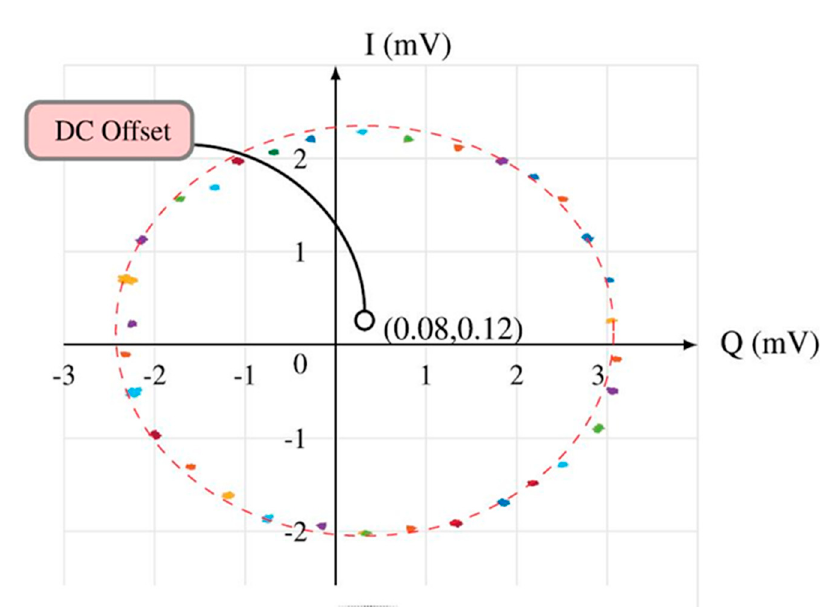
Figure 49. I/Q points over 1 GHz frequency shift. Figure 49. I / Q points over 1 GHz frequency